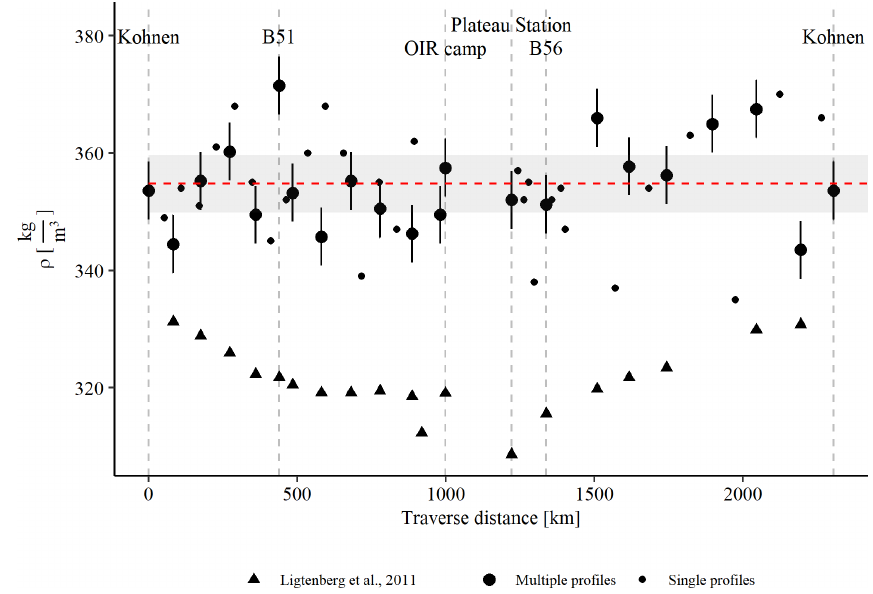
Figure 11. Location mean density ( ρ loc ) as well as liner density ( ρ L ) along one leg of the traverse route, from Kohnen Station to B51, further along the ice divide to B53 and from Plateau Station straight back to Kohnen Station. σ n calculated from the OIR trench (Sect. 3.3) is given by vertical error bars at each location. A mean density value for Kohnen Station was calculated from samples not collected in this study (Sect. 2.5). The red dashed horizontal line indicates the mean density along the whole traverse, and the standard error ( σ n ) is indicated with grey shading. The triangles show the parameterized density values according to Ligtenberg et al.